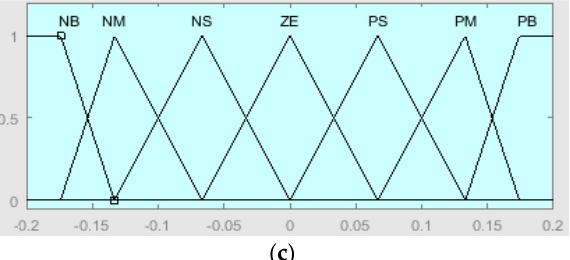
Figure 15. Input ( a , b ) and Output ( c ) Membership Functions of F-LC for PV System. Table 7. Rule Base of F-LC for PV System.